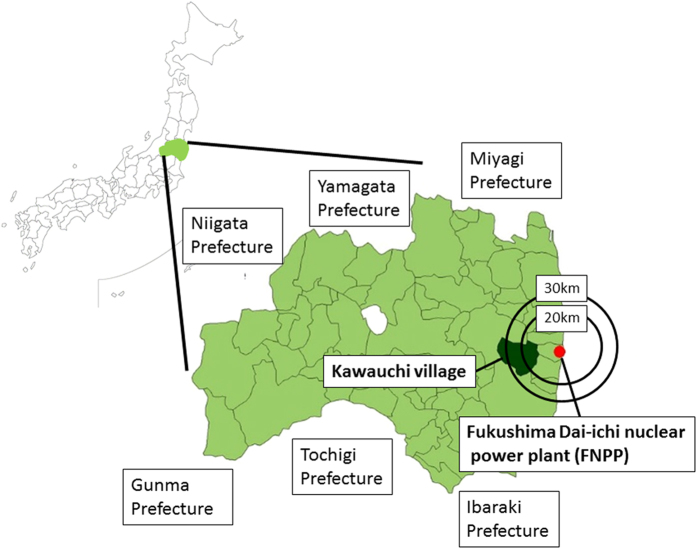
Location of Kawauchi Village, Fukushima Prefecture.The first author (M.O.) created the map using the software (Zenrin Electric Map Z i17®, ZENRIN CO., LTD., Tokyo, Japan. http://www.zenrin.co.jp/product/gis/zmap/zmaptown.html).